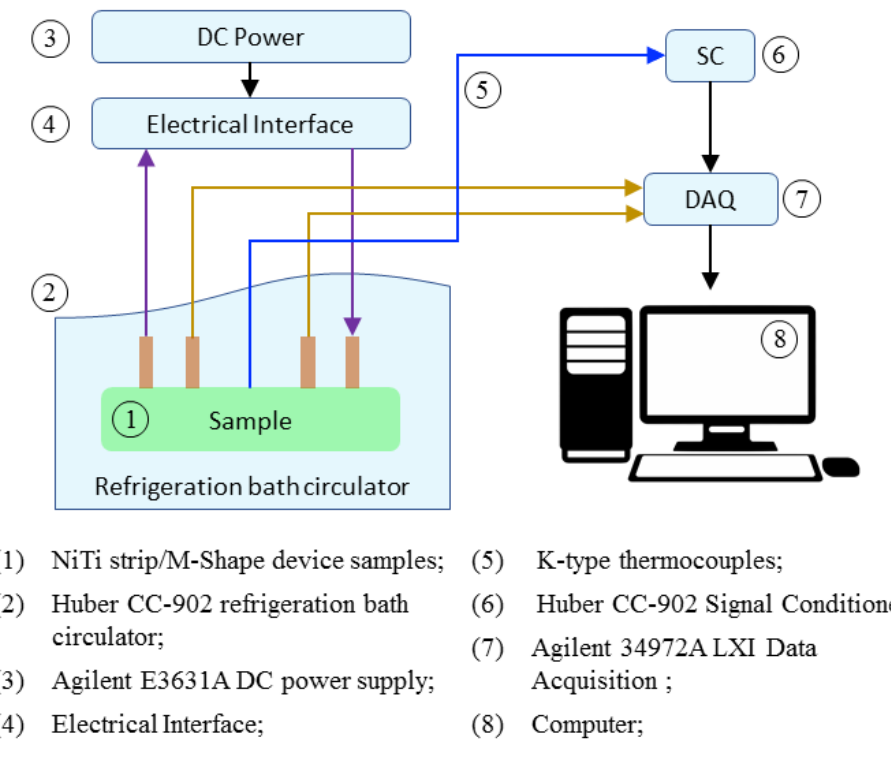
Figure 5. Schematic of the ERFT experiment.